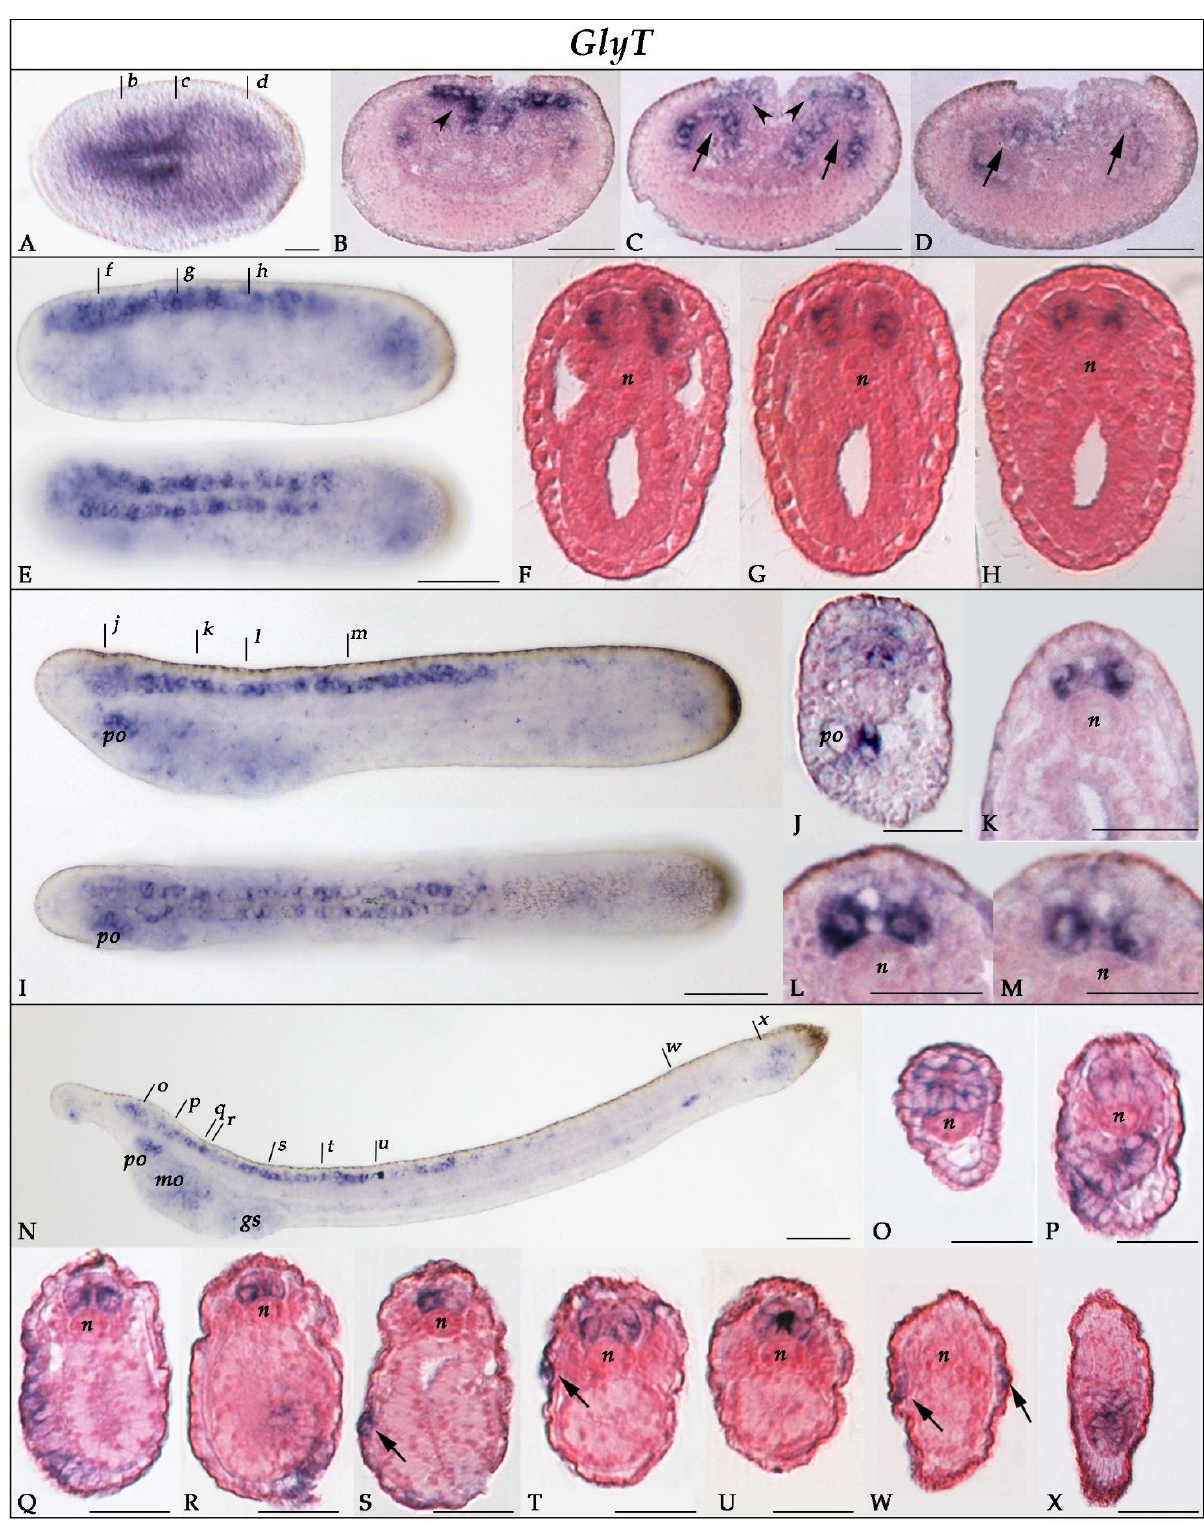
Figure 3. Expression of GlyT in developing amphioxus. ( A ) Whole mount N1-stage neurula in dorsal view, anterior to the left. ( B – D ) Cross-sections of a N1 neurula at levels indicated in ( A ) by the corresponding lowercase letters. GlyT is expressed in the anterior neural plate (arrowheads in B , C ) and in the forming somites (arrows in C , D ). ( E ) Whole mount N4-stage neurula in lateral (top) and dorsal (bottom) view, anterior to the left. ( F – H ) Cross-sections of a N4 neurula at levels indicated in ( E ) by the corresponding lowercase letters. GlyT -expressing cells are arranged in two lateral columns in the